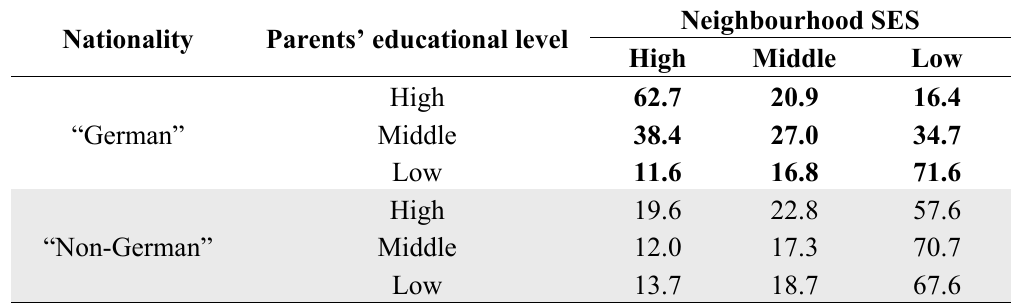
Nationality Parents’ educational